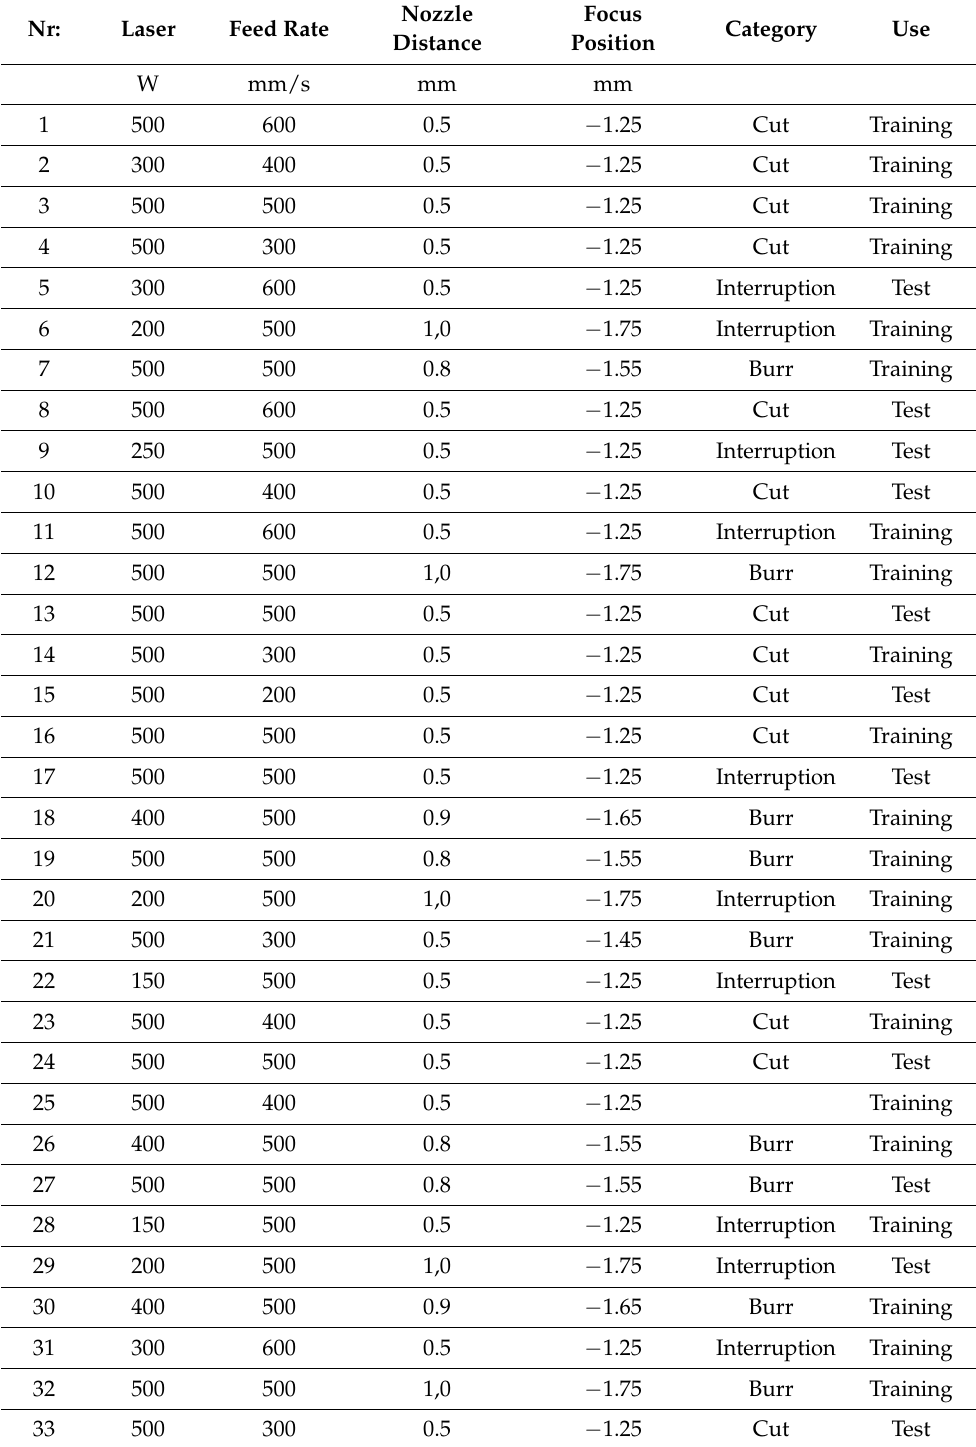
Table of all performed laser cuts with machine parameters, cut category and use for training and